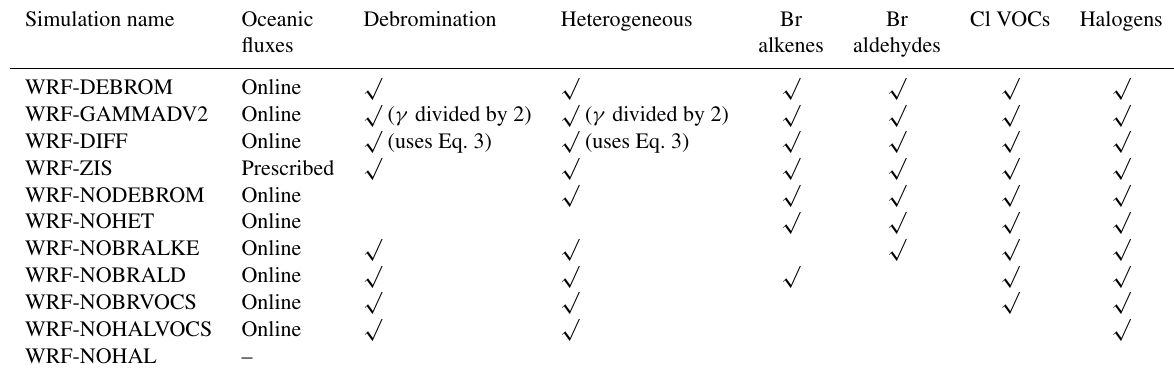
Table 7. Summary of all the simulations to investigate the main processes involving reactions between halogen